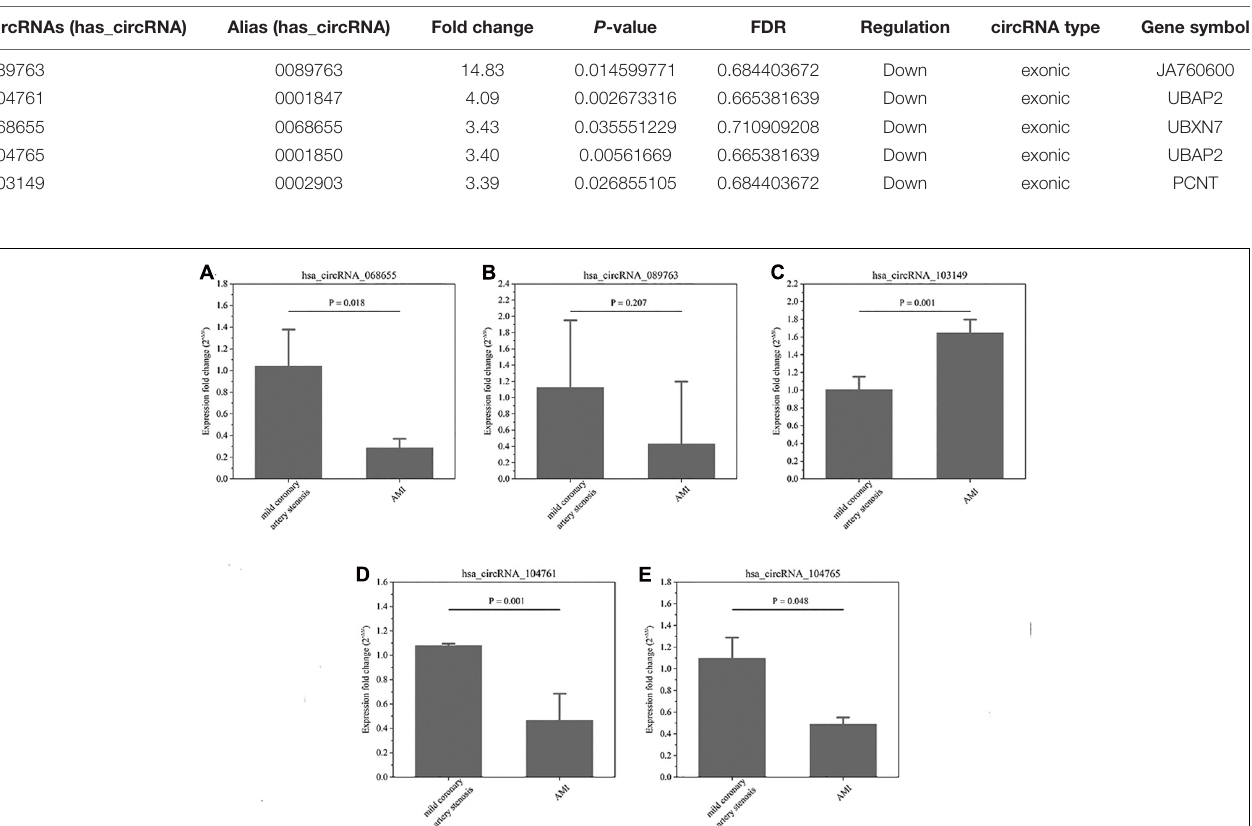
TABLE 1 | Five typical down-regulated circRNAs in AMI patients identified by microarray analysis. circRNAs (has_circRNA) Alias (has_circRNA) Fold change P -value FDR